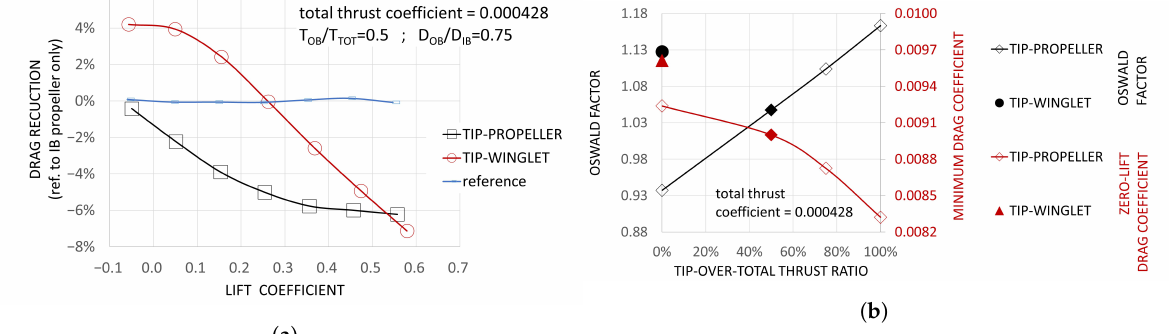
Figure 28. Comparison of wing aerodynamic performance with tip winglet or tip propeller, against ref- erence configuration, in cruise flight conditions: ( a ) Relative drag reduction regarding standard case (STD, Table 3); ( b ) Oswald factor and zero-lift drag